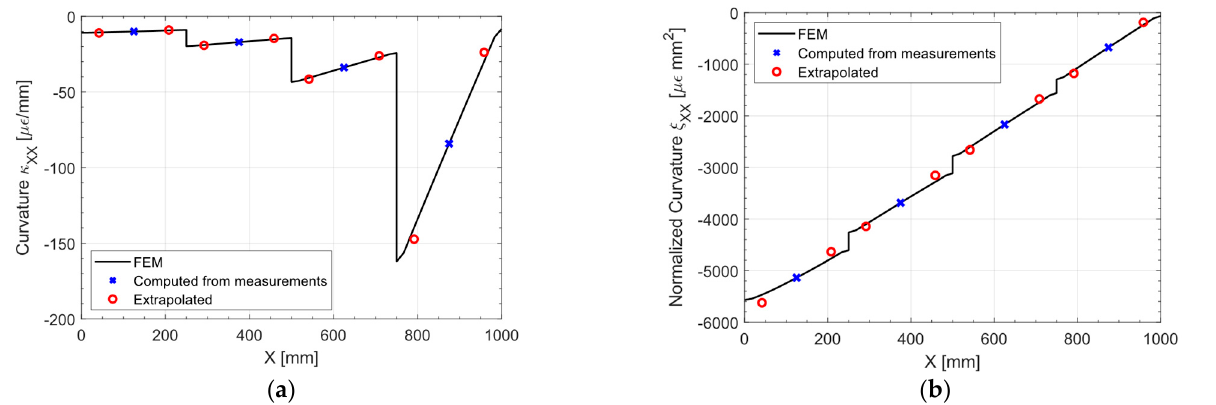
Figure 11 . ( a ) out-of-plane tip loading: curvature 𝜅 (cid:3025)(cid:3025) and ( b ) normalized curvature 𝜉 (cid:3025)(cid:3025) , slice at Y Figure 11. ( a ) out-of-plane tip loading: curvature κ XX and ( b ) normalized curvature ξ XX , slice at = 250 mm. Y = 250 mm.